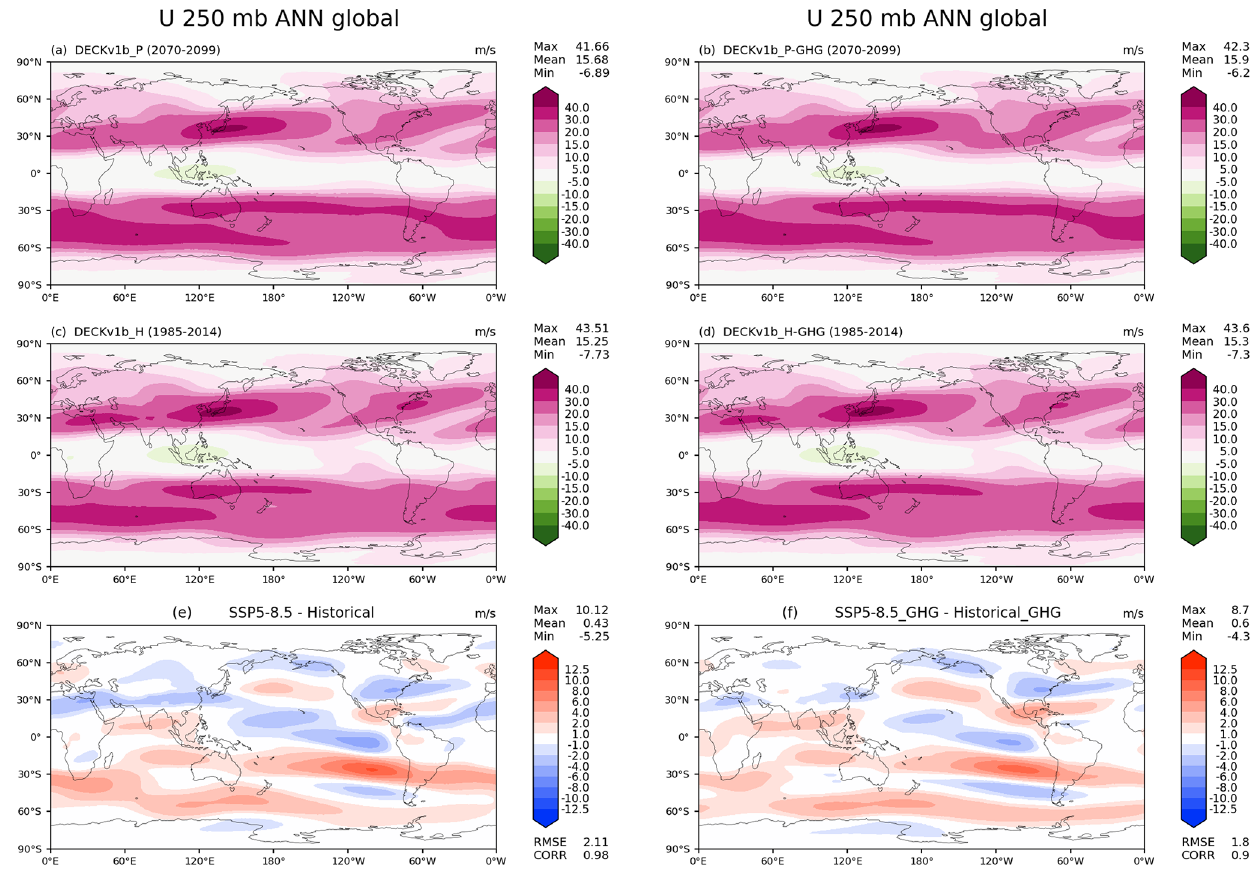
Figure 4. Annual mean 250hPa zonal wind (ms − 1 ) from (a) five SSP5.85 ensemble simulations (2070–2099), (c) five historical ensemble simulations (1985–2014), and (e) the change between the time period of 2070–2099 and the period of 1985–2014. Annual mean 250hPa zonal wind (ms − 1 ) (b) three SSP5.85-GHG ensemble simulations (2070–2099), (d) three historical-GHG ensemble simulations (1985–2014), and (f) the change between the time period of 2070–2099 and the period of